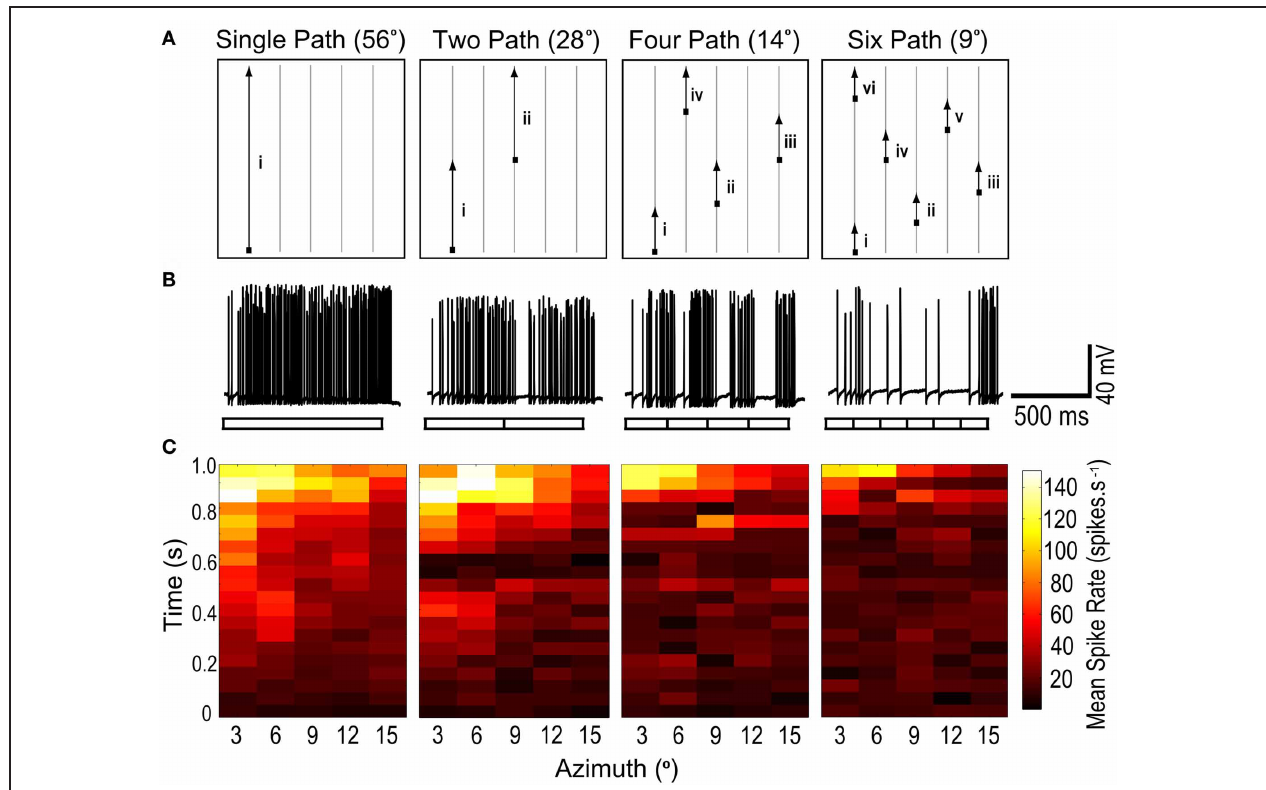
FIGURE 1 | (A) A moving target with its path segmented into varying lengths, is presented within a region of interest (ROI) of CSTMD1’s receptive field. For the single path variant, the target moves vertically to the top of the ROI. For two paths, the target traverses midway before jumping to a new horizontal location. Similarly, shorter segment lengths result in multiple jumps. A stimulus set is composed of five such traversals, each started from the bottom of the ROI, at varying horizontal locations. Thus for any segment length variant, an individual path is traversed only once and the entire ROI is covered. (B) Raw responses to 1 of the 5 traversals, for each of the 4 segment length variants (56 ◦ , 28 ◦ , 14 ◦ , and 9 ◦ ). The neuronal response to a